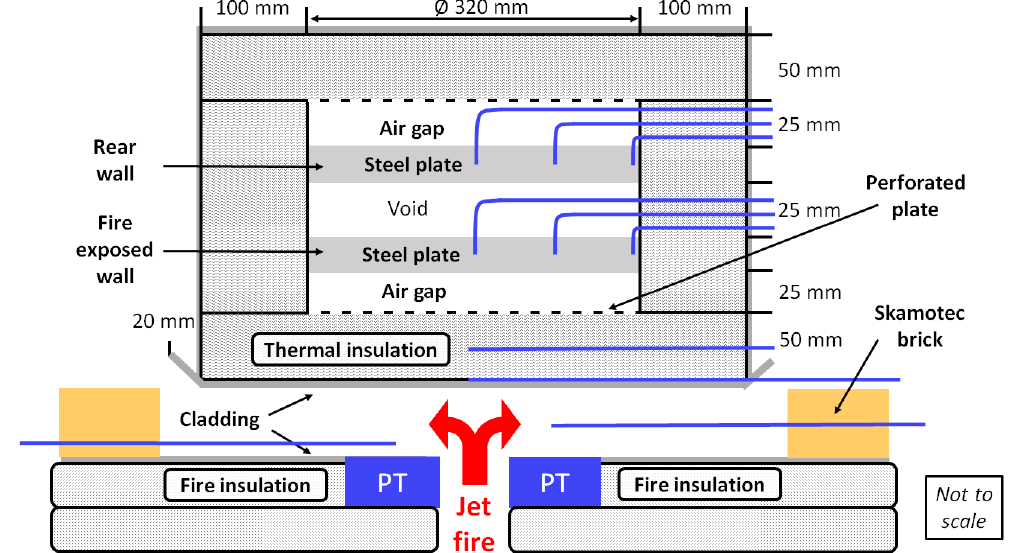
Figure 2. Sketch of mockup including flame zone, type K mantle thermocouples (blue lines), flush mounted plate thermometers (marked PT) and Skamotec bricks.